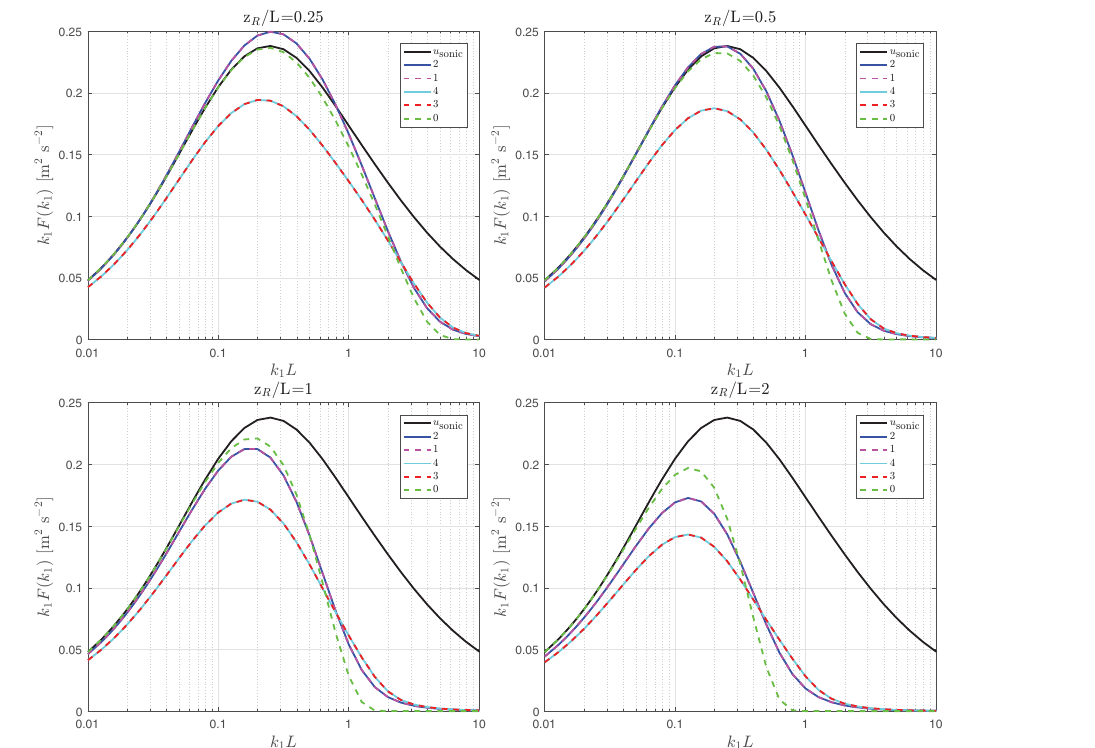
Figure 3. Sonic and pulsed lidar velocity spectra from Eqns. (3) and (6) corresponding to the beams shown in Fig. 1-right. Values of z R /L are indicated, ϕ =15 ◦ , Γ=3 , and αε 2/ 3 =0.1 m 4/ 3 s − 2